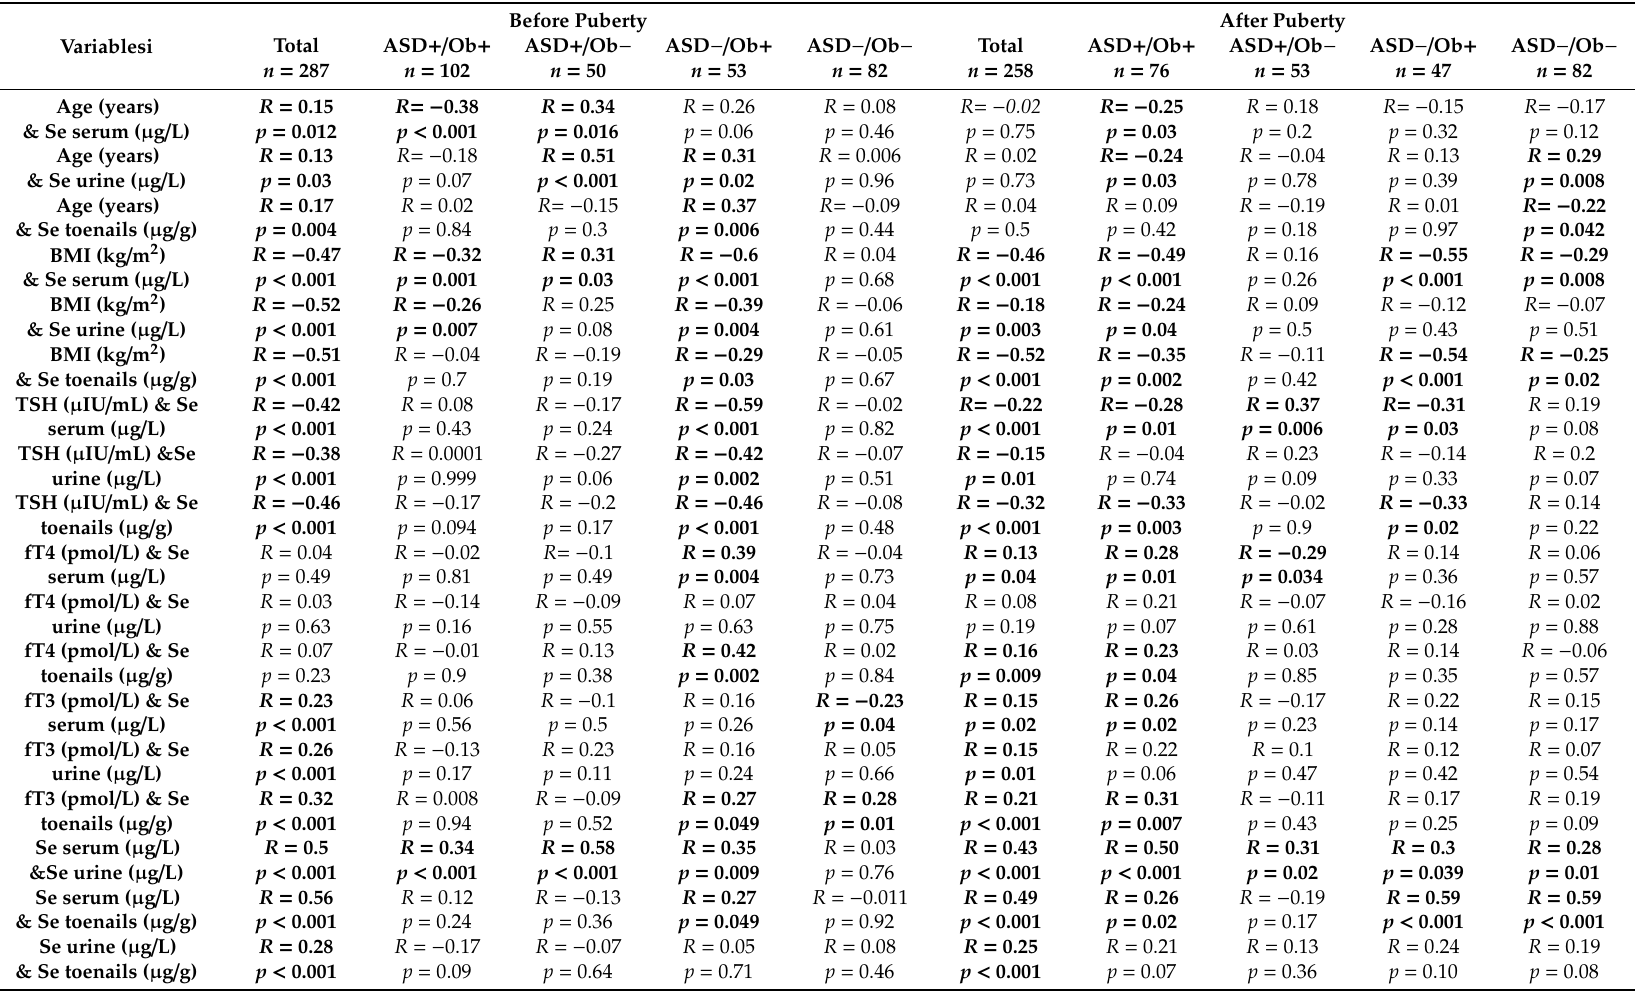
Table 2. Inter-correlations between age, BMI, thyroid stimulating hormone (TSH), fT3, fT4 and serum, urine and toenail selenium concentrations. Statistically significant correlations are highlighted. Spearman’s rank-order correlation test